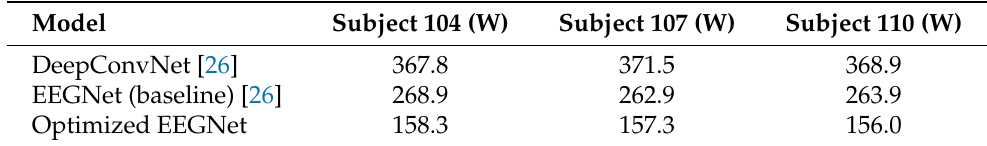
Table 5. Average Power Consumption during